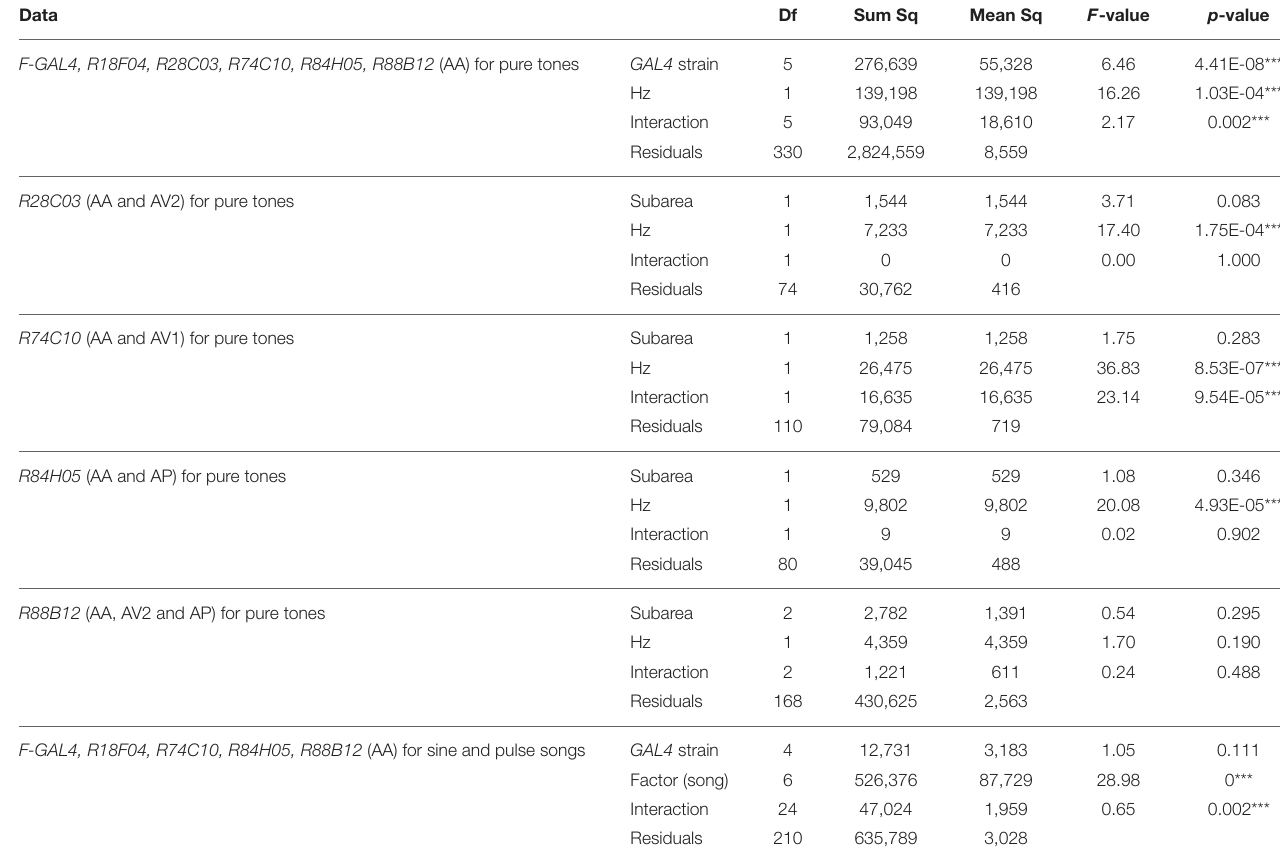
TABLE 4 | Statistical comparison of Ca 2 + response property among GAL4 strains, subareas, and stimuli. Data